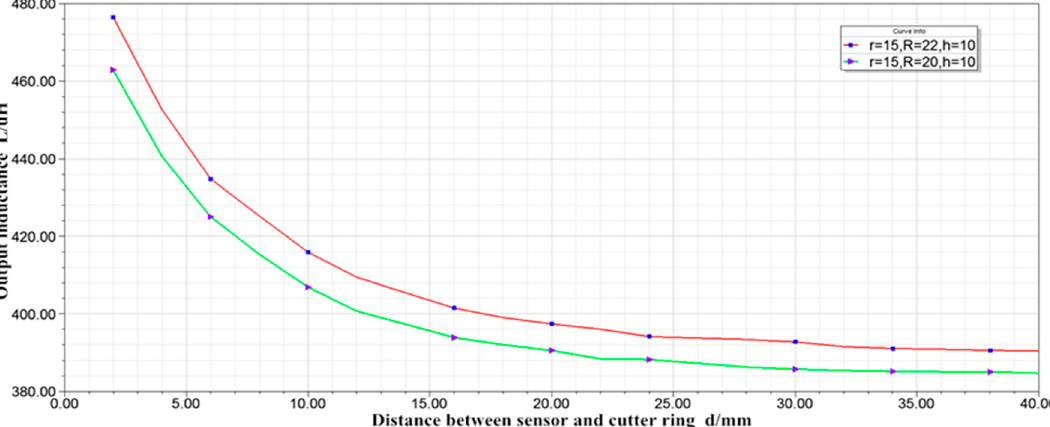
Figure 7. Characteristic curve of inductance displacement.